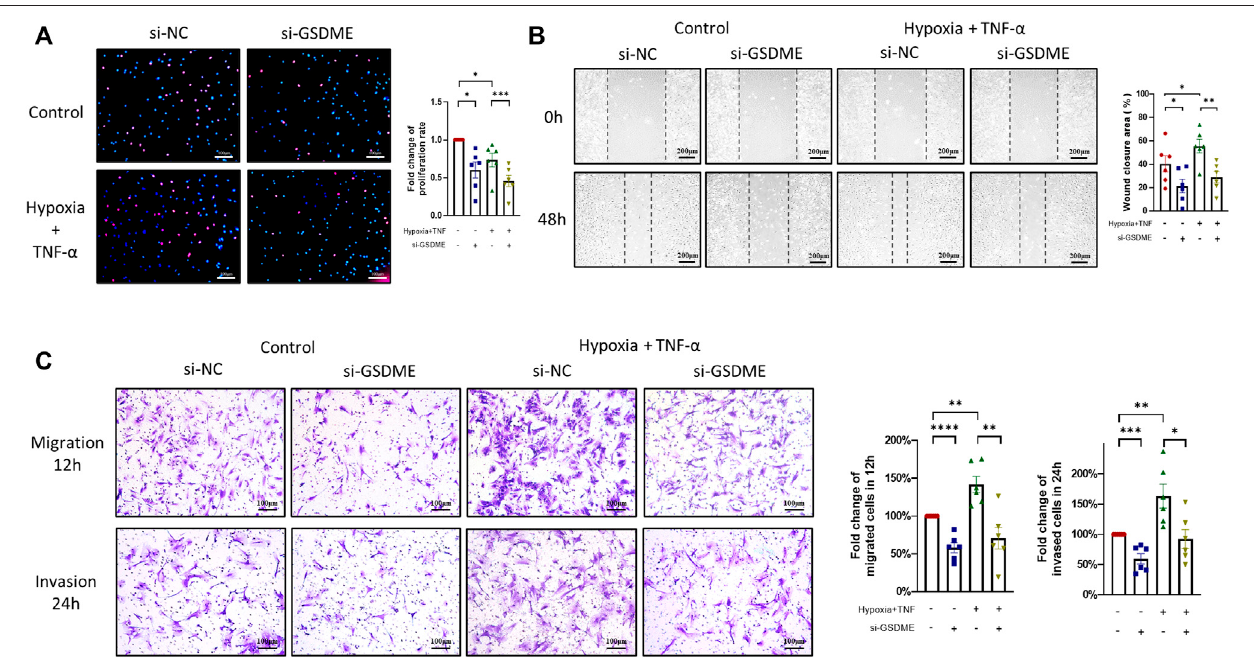
FIGURE4| Suppressionofproliferation,migrationandinvasionofRA-FLSsthroughinhibitionofGSDME-mediatedpyroptosis. (A) DecreaseinRA-FLSsproliferation byknockdownofGSDMEmeasuredbyEdUexperiment( n =6,scalebar=100 μ m). (B,C) InhibitionofRA-FLSsmigrationand invasionactivitiesbyGSDMEknockdown. After 24 h of transfection with GSDME siRNA (si-GSDME) or control siRNA (si-NC), RA-FLSs migration was determined by wound healing assay (B, n = 6, scale bar = 200 μ m)andtranswellchamberassay(C, n =6,scalebar=100 μ m),invasionwasdeterminedforbymatrigel-coatedtranswellassay(C, n =6,scalebar=100 μ m). Data are shown as mean ± s.e.m and results are representative of three independent experiments. * p < 0.05, ** p < 0.01, *** p < 0.001, **** p < 0.0001 using one-way ANOVA.